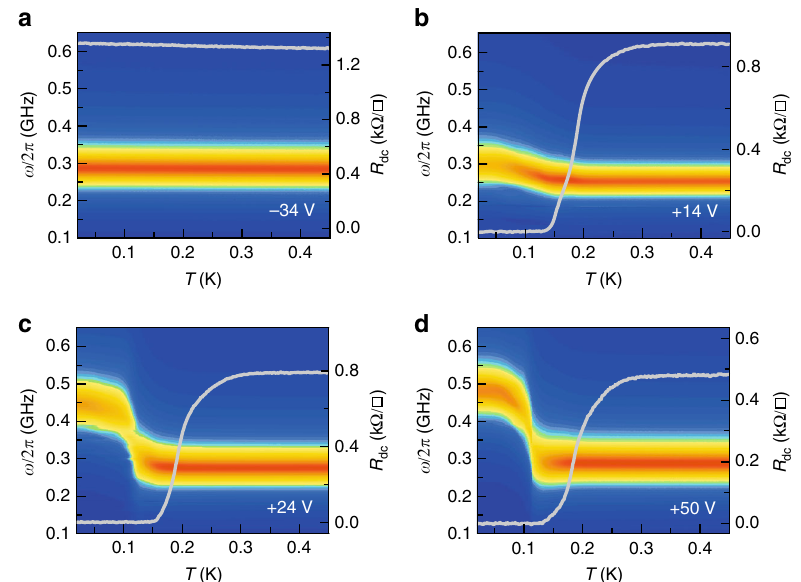
Fig. 3 Resonance of the sample circuit in the superconducting state. Magnitude of Γ ( ω ) in dB (color scale) as a function of frequency and temperature for the selected gate values, V G = − 34 V ( a ), V G = +14 V ( b ), V G = +24 V ( c ), and V G = +50 V ( d ). The corresponding dc resistance as a function of temperature is shown in gray solid lines (right axis)